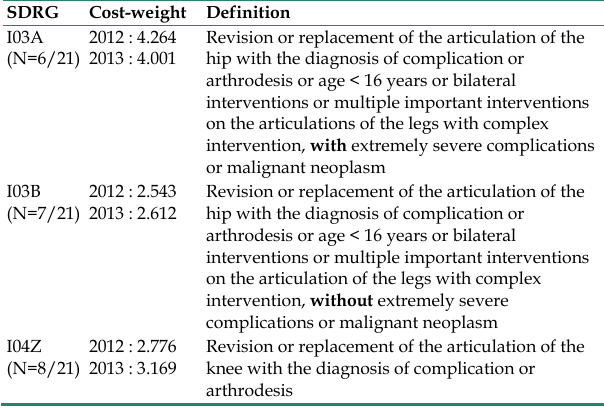
Table 1. SDRGs for prosthetic joint infections.